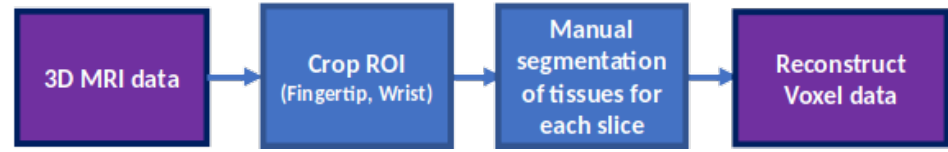
Figure 5. MR image data segmentation process. Fingertip